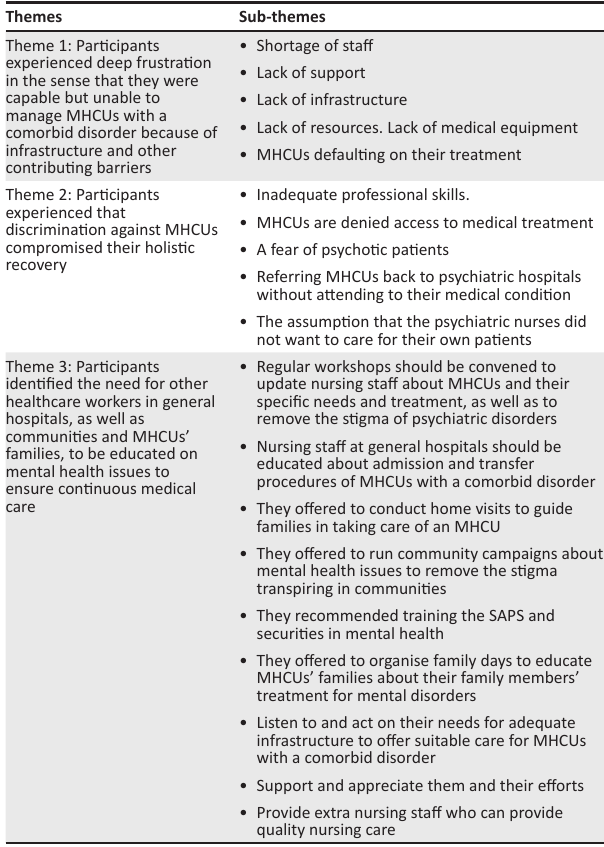
TABLE 2: Themes of the lived experiences of psychiatric nurses caring for mental healthcare users with a comorbid disorder in a psychiatric hospital in Limpopo